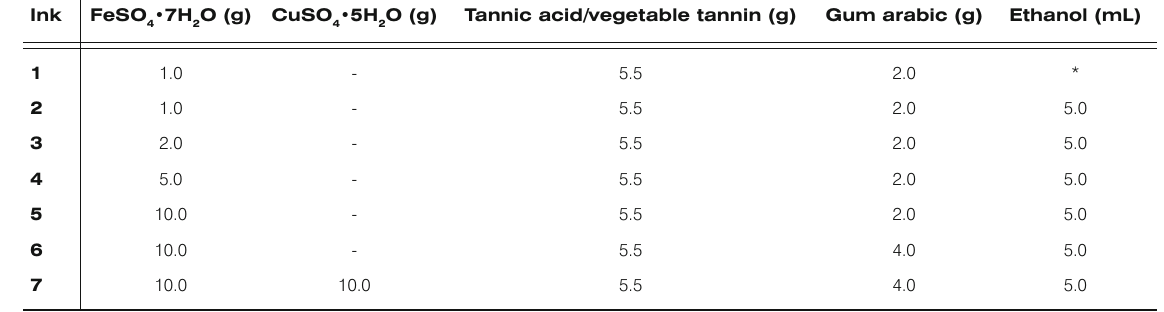
Table 1. Iron-gall inks preparations used in the present work. Ink FeSO